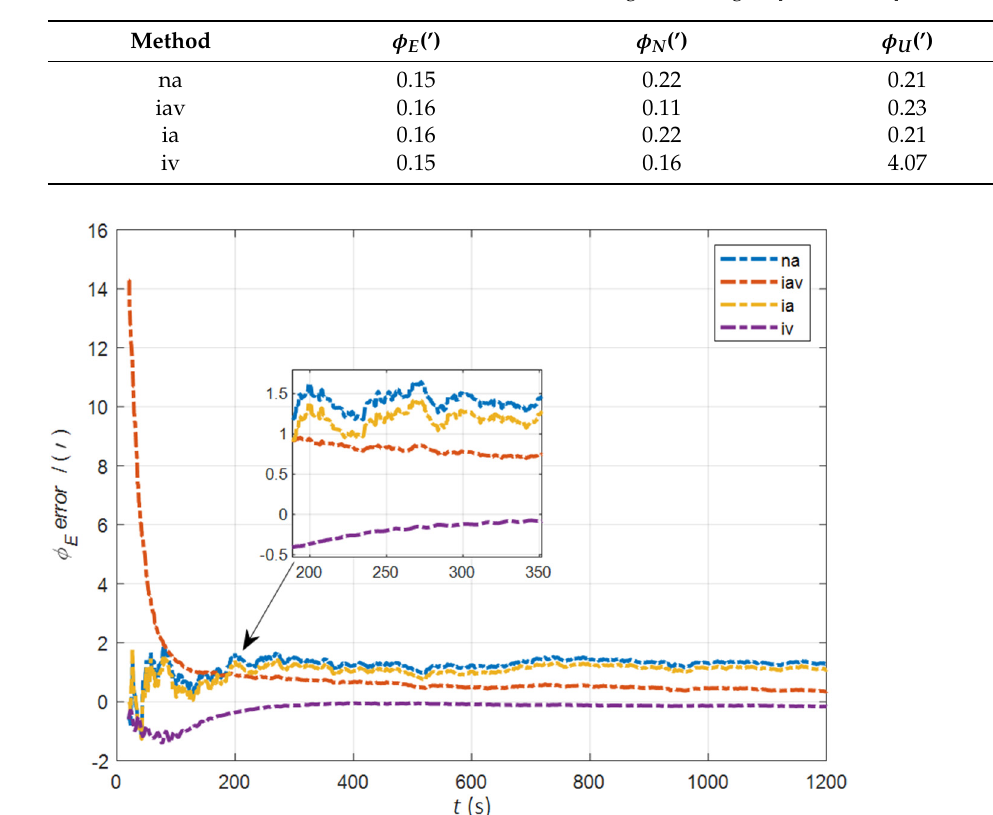
φ in the cases of the initial misalignment angles E